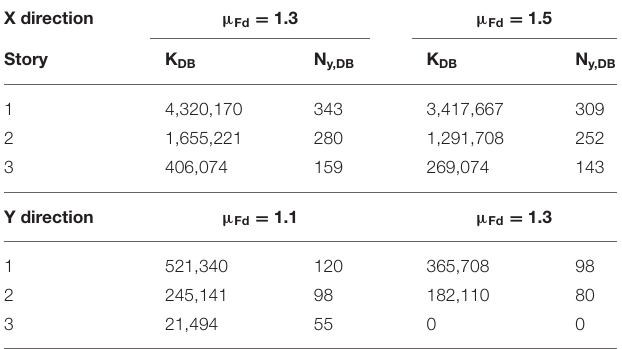
TABLE 3A | Stiffness (kN/m) and strength (kN) of the HYDBs (case A, LS limit state). X direction µ Fd = 1.3 µ Fd = 1.5